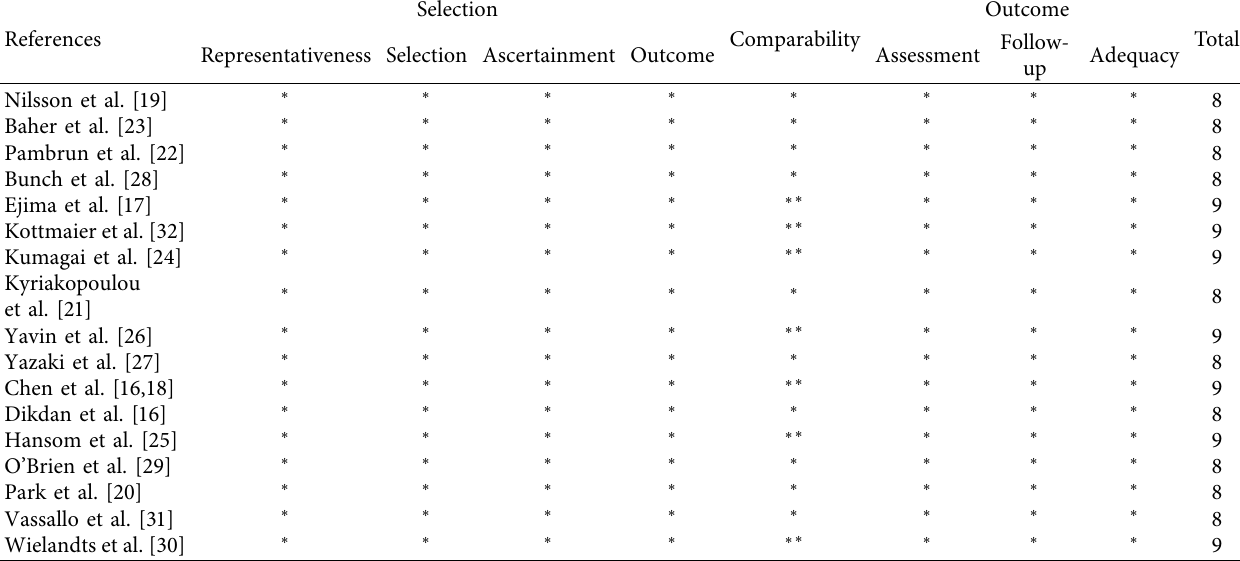
Table 3: Newcastle–Ottawa scale scores and quality assessment of included